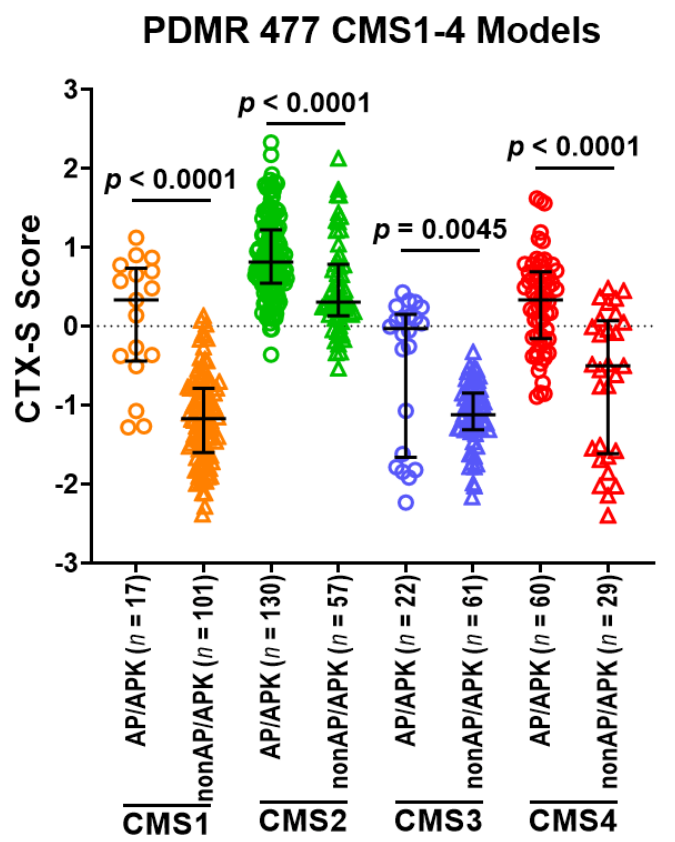
Figure 9. Comparison of CTX-S scores in AP/APK vs. nonAP/APK in each of four CMS classes in PDMR CRC models. Bars represent median with interquartile range. p values are for two-tailed Welch t test.